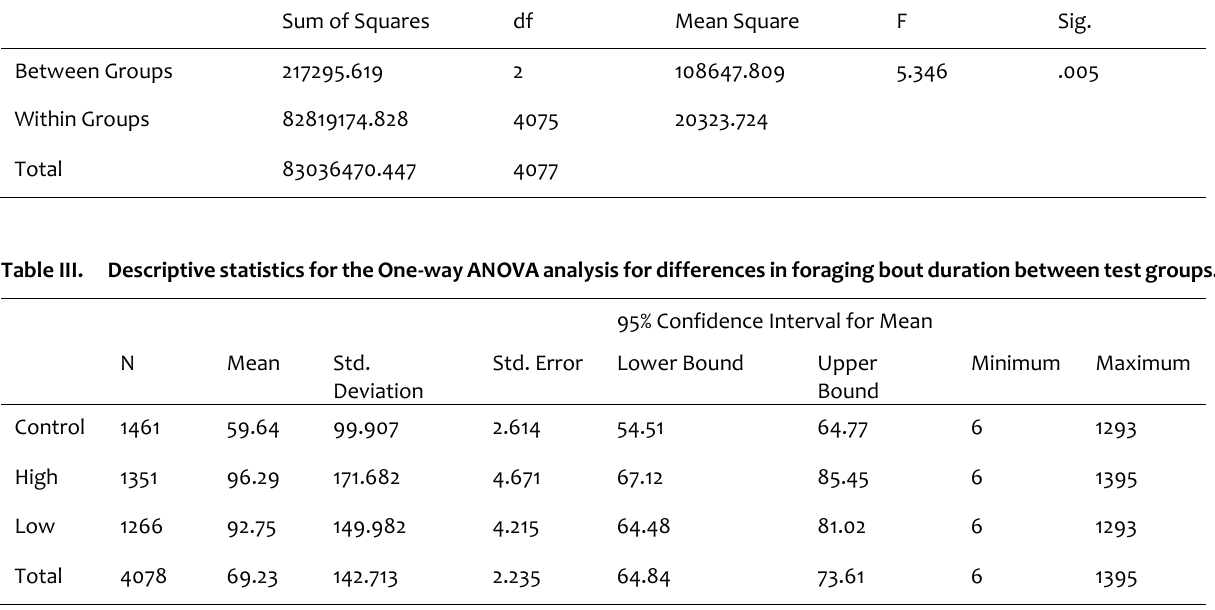
Table II. Overview of the One-way ANOVA analysis for differences in foraging bout duration between test groups.